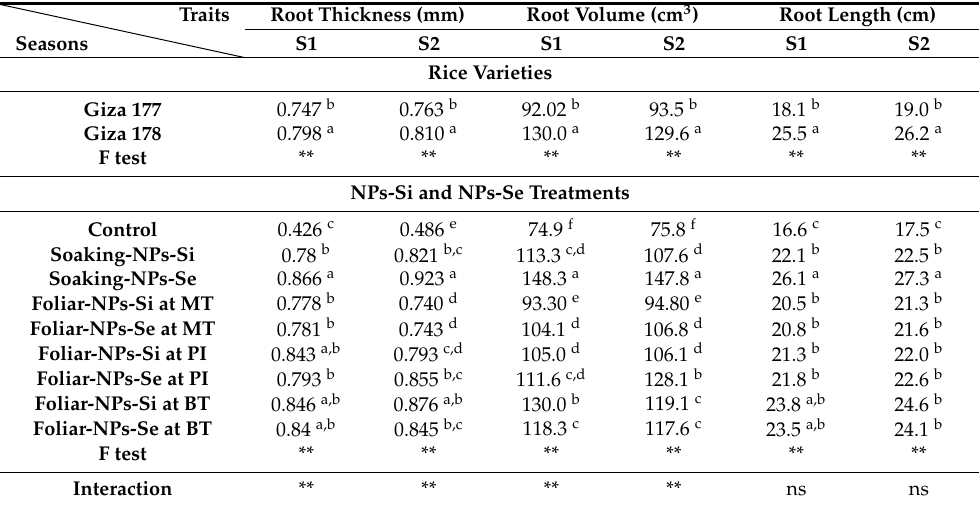
Table 2. Effect of NPs-Si and NPs-Se treatments on root thickness, root volume, and root length of two rice varieties under saline soil conditions in the 2018 (S1) and 2019 (S2)